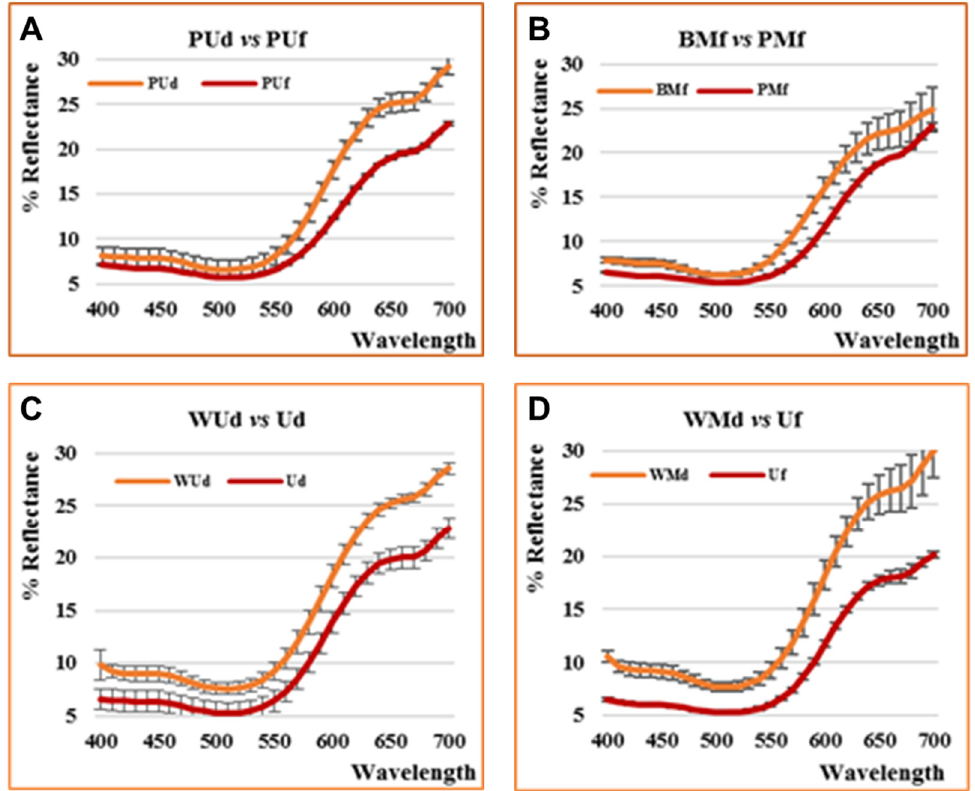
Figure 2. Reflectance curves of some selected homogenates: (A) comparison between PUd and PUf; (B) comparison between BMf and PMf; (C) comparison between WUd and Ud; (D) comparison between WMd and Uf. Each reported profile represents the mean of four measurements.